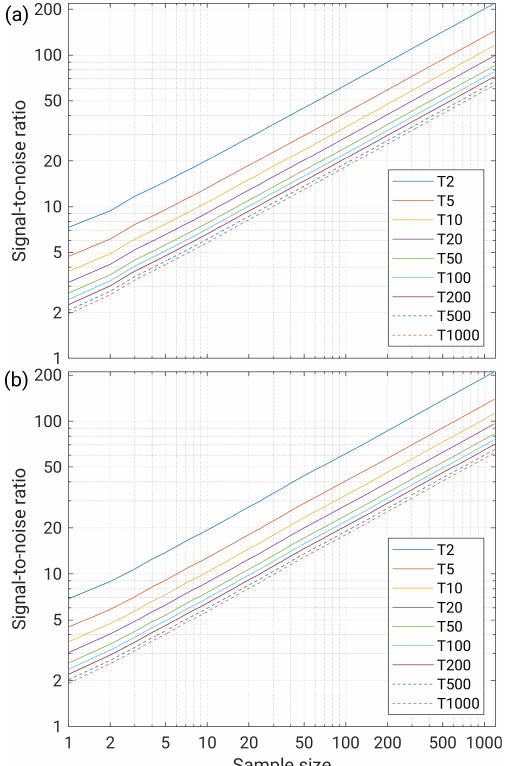
Figure 5. S2N ratio for different return periods T (colored lines) of daily spatial mean precipitation dependent on the sample size for (a) ME ∗ and (b) AL ∗ . The LAERTES-EU members were randomly stringed together permuting the order a hundred times. The shown S2N is the mean of this